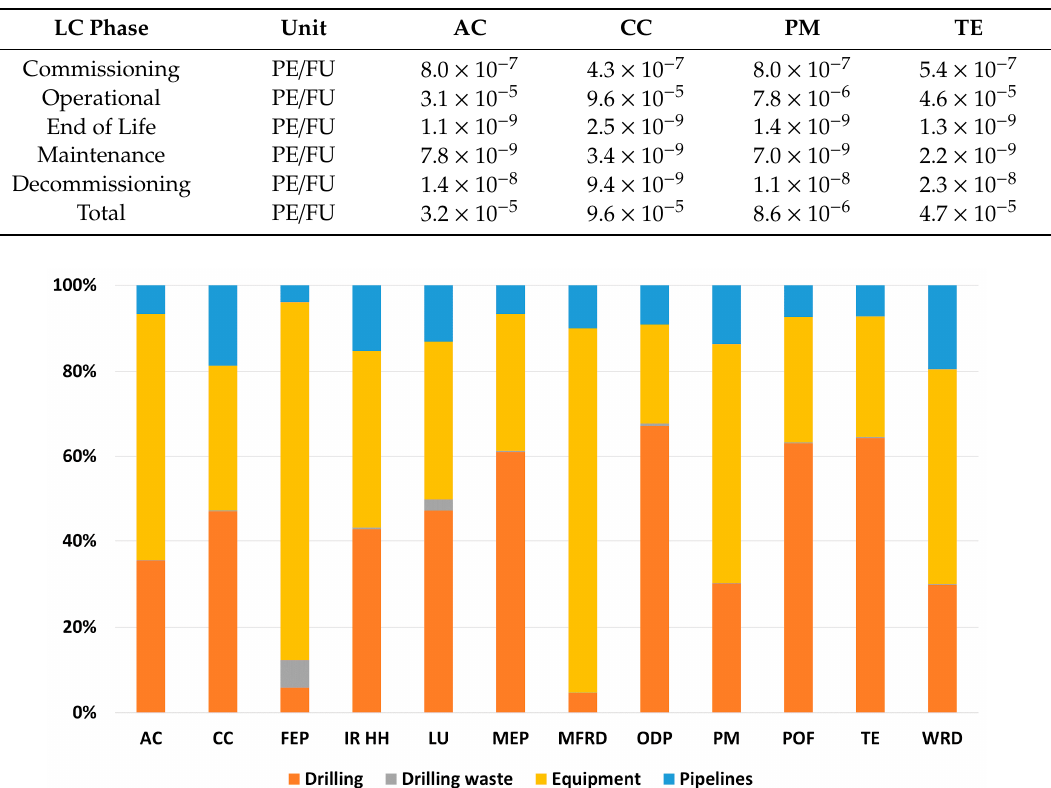
Figure 4. Percentage of contribution from drilling, drilling waste disposal, equipment and pipelines to the commissioning phase.